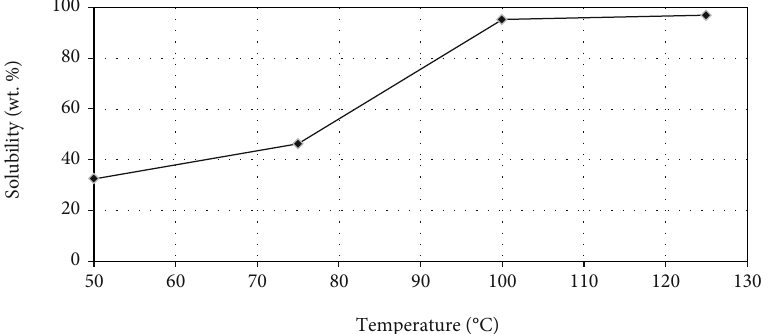
Figure 5: Hematite solubility in 12.5vol.% HCl at di ff erent temperatures.